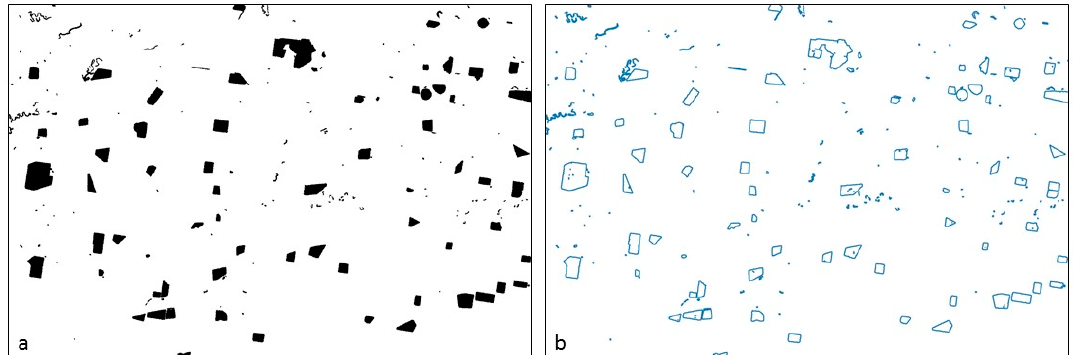
Figure A3. Polygonisation process to transfer pixels identified as waterbodies ( a ) into polygons ( b ).